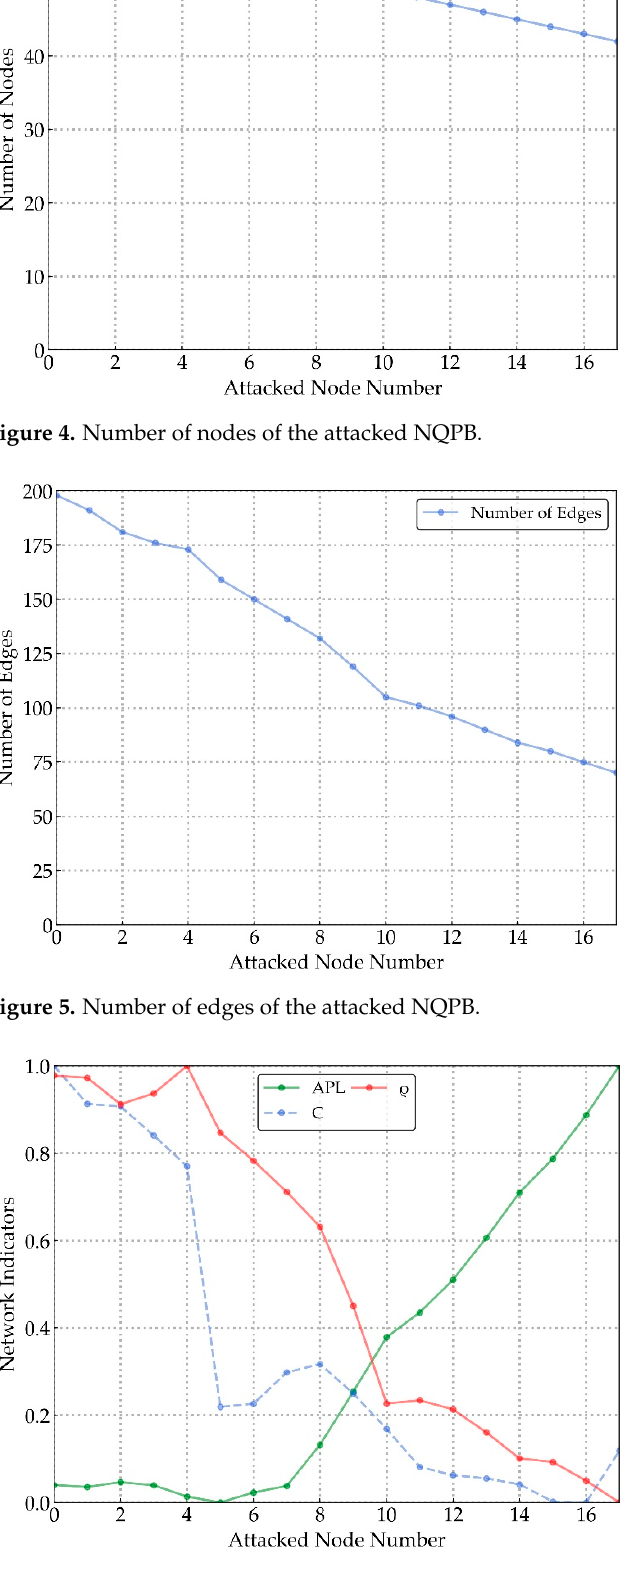
Figure 6. NQPB indicators after being attacked.